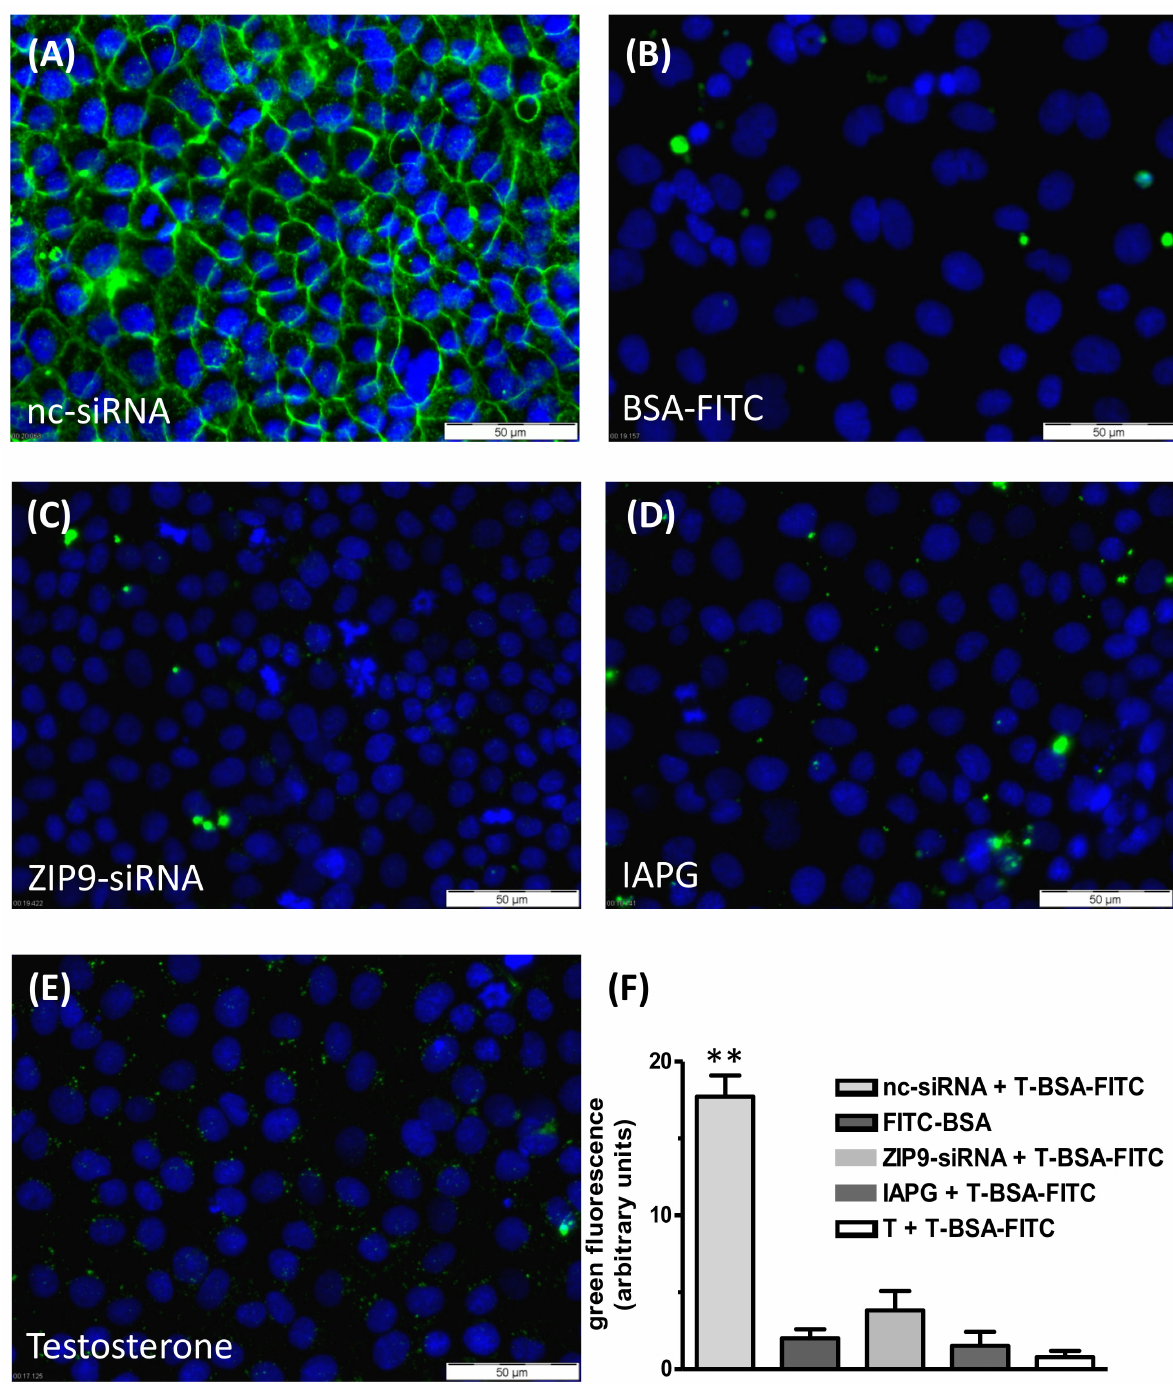
Figure 4. Testosterone-BSA-FITC (T-BSA-FITC) membrane labeling of PASC1 cells. T-BSA-FITC or BSA-FITC are visualized as green fluorescence and nuclei are stained blue. ( A ) T-BSA-FITC labeled membranes of cells treated with nc-RNA. ( B ) BSA-FITC lacking the testosterone moiety did not stain the membranes. ( C ) There was also no staining after ZIP9 knockdown. ( D ) IAPG (10 µ M) or ( E ) testosterone (10 nM) prevented membrane labeling by T-BSA-FITC. ( F ) Statistical analysis of the green fluorescence ( n = 28; means ± SEM; ** p ≤